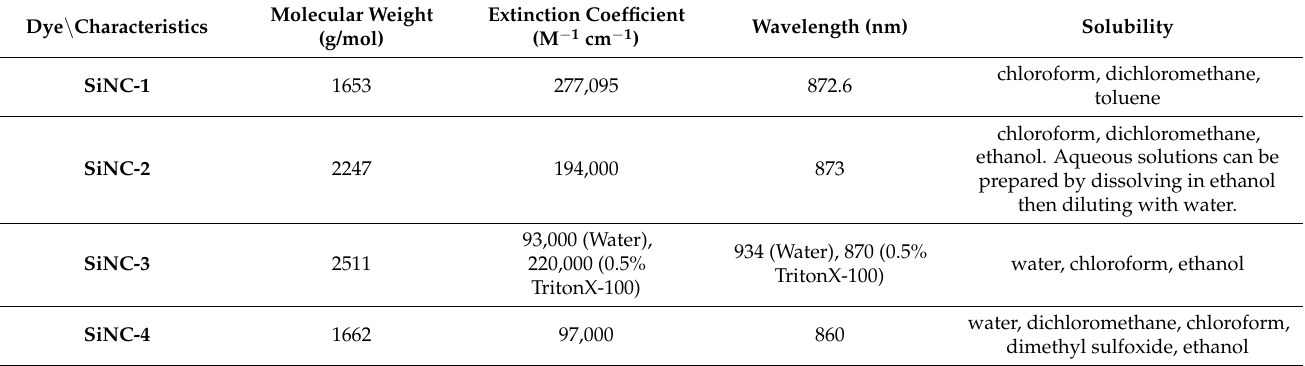
Table 1. Physicochemical characterization of silicon naphthalocyanine dyes (SiNC(1–4)). Dye \ Characteristics